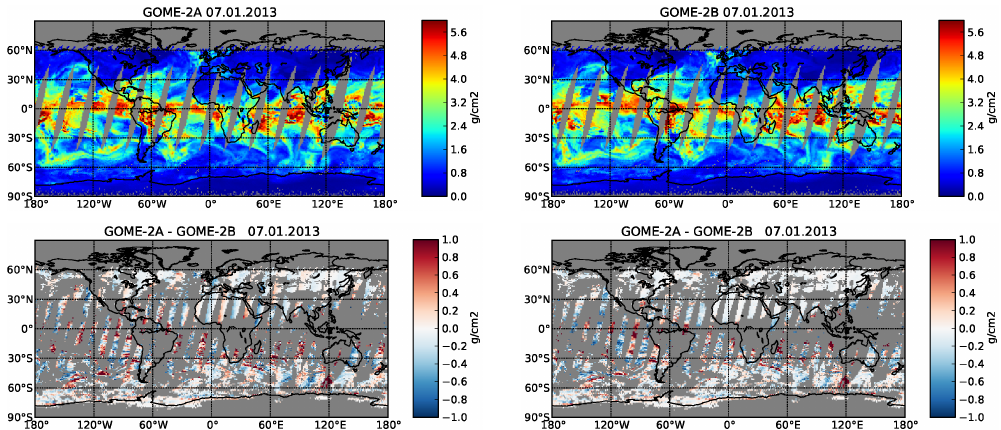
Figure 4. Top panels: daily averages of H 2 O total columns from GOME-2A and GOME-2B for the 7 January 2013 with SAD correction applied. Only data corresponding to solar zenith angles lower than 87 ◦ are used. GOME-2A and GOME-2B measurements are separated by approximately 48min in time. Bottom panels: geographical distribution of the differences between GOME-2A and GOME-2B total column water vapour for the 7 January 2013 when the SAD correction is applied to the two data sets (right panel, GDP 4.7) and without SAD correction (left panel, GDP 4.6). Cloud-free co-located measurements are shown in the plot.